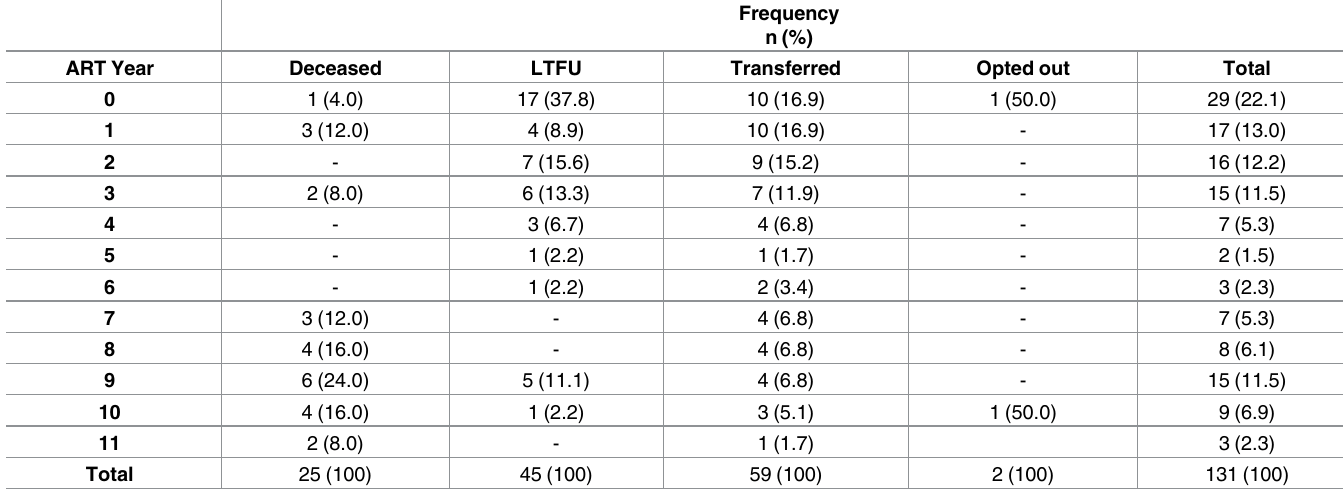
Table 4. Time to death, loss to follow-up, transfer out or opting out of care in yearssince ART commencement (n =